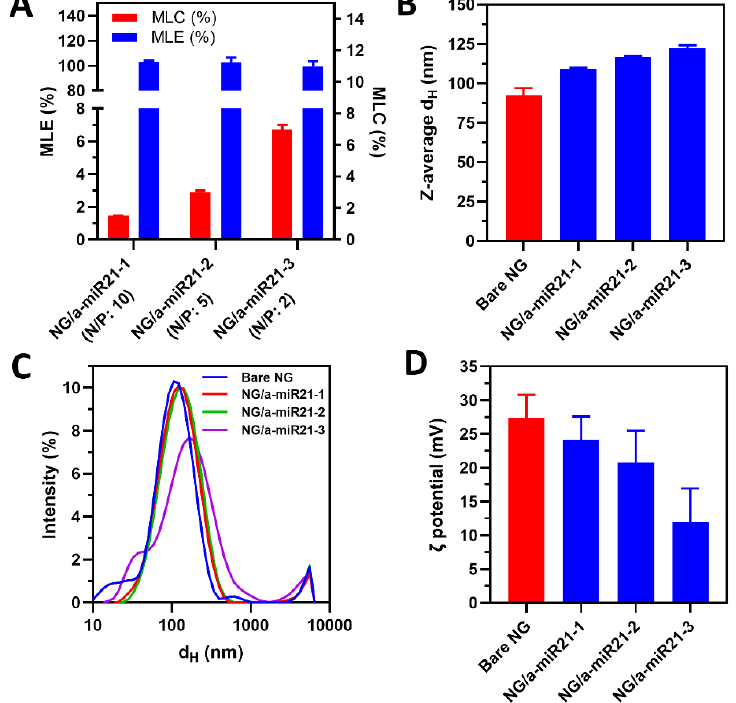
Figure 2. NG/miRNA characterization. ( A ) MLC and MLE of NG/a-miR21-1,2,3. ( B , C ) Z-average hydrodynamic diameter (d H ) of bare NG and NG/a-miR21-1,2,3 in 1 mM KCl measured by DLS. ( D ) ( D ) ζ potential of bare NG and NG/a-miR21-1,2,3 nanogels in 1 mM KCl measured by ELS. Data ζ potential of bare NG and NG/a -miR21-1,2,3 nanogels in 1 mM KCl measured by ELS. Data are reported as the mean ± SD (n = 4).